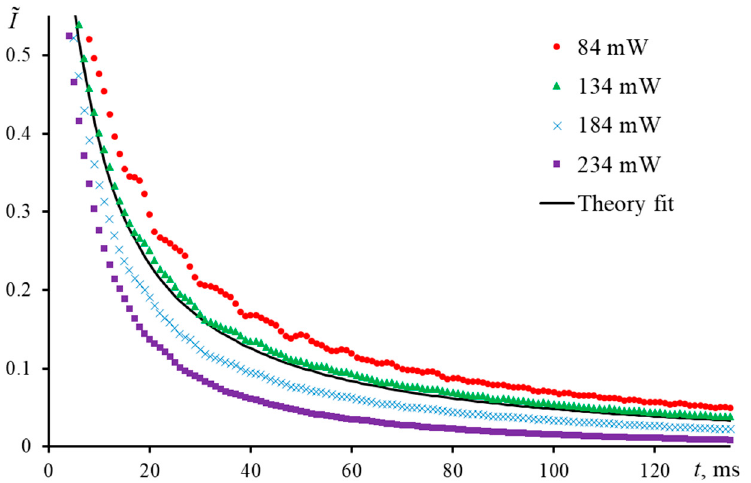
18 of 32 Figure 13. Normalized transient curves of aqueous solutions of ferroin with different concentration; narrow-focused configuration ( 𝜔 (cid:3032)(cid:2868) = 33 µm, Figure 1, Table 3). Another sign of the discussed effect can be the transient curves of the same sample obtained at different powers of the excitation beam. Let us consider this case by the exam- ple of the middle-focused configuration, where measurements were made of a 2.5 µmol/L Sudan I ethanol solution (Figure 14). With an increase in the excitation power from 84 to 234 mW, the curve shape changes, which leads to a change in the apparent characteristic time. This change should not be true, since there are no changes in the solution composi- tion (phase transitions, chemical reactions, etc.). At the same time, if in the first case, where the behavior of transient curves for samples with different concentrations (obviously high) was considered, the experiment correlated with theory only in the case of very dilute